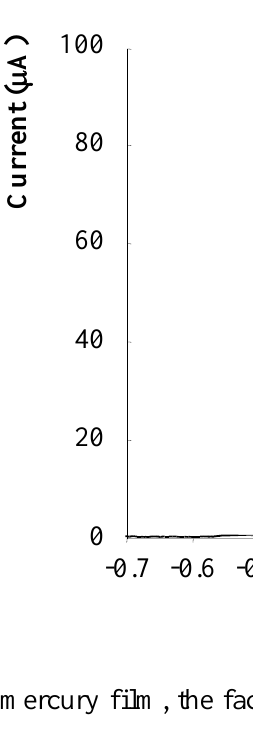
Figure 1. Differential Pulse Anodic Stripping Voltammogram of 10 –6 M Sb (III) in 3.00 M HCl, E = –0.70 V and t = 718 s, using a mercury film modified graphite screen- dep dep printed electrode (Mercury film: C = 800 mg/l, E = –0.90 V and t = 600 Hg dep dep